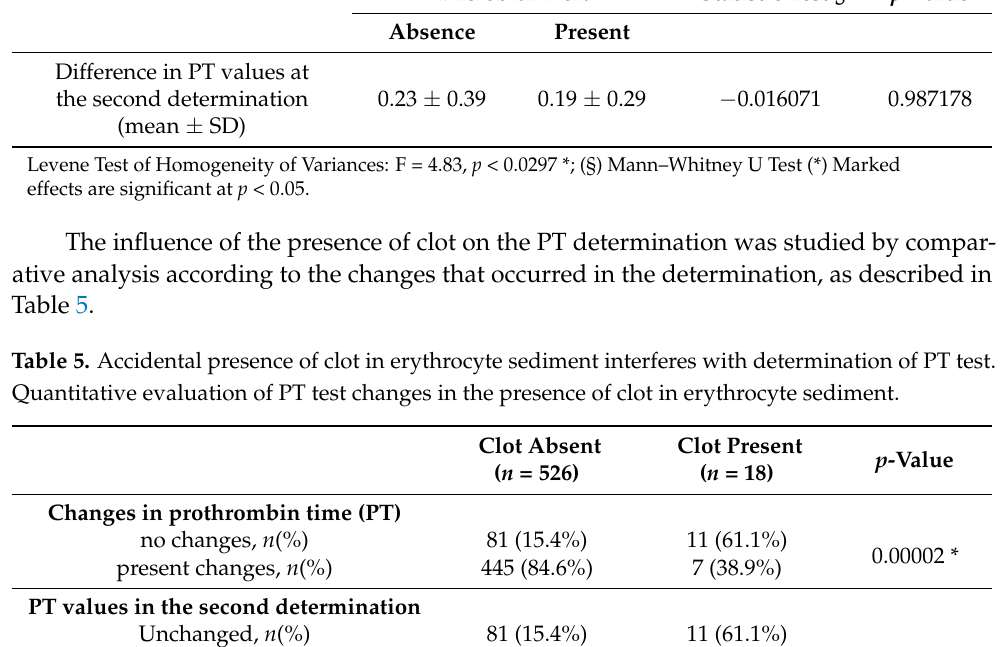
Table 4. Mean values and statistical indicators of the difference between PT values at the second determination and microbial flora. Microbial Flora Statistic Test § p -Value Absence Present Difference in PT values at the second determination 0.23 ± 0.39 0.19 ± 0.29 − 0.016071 0.987178 (mean ± SD)